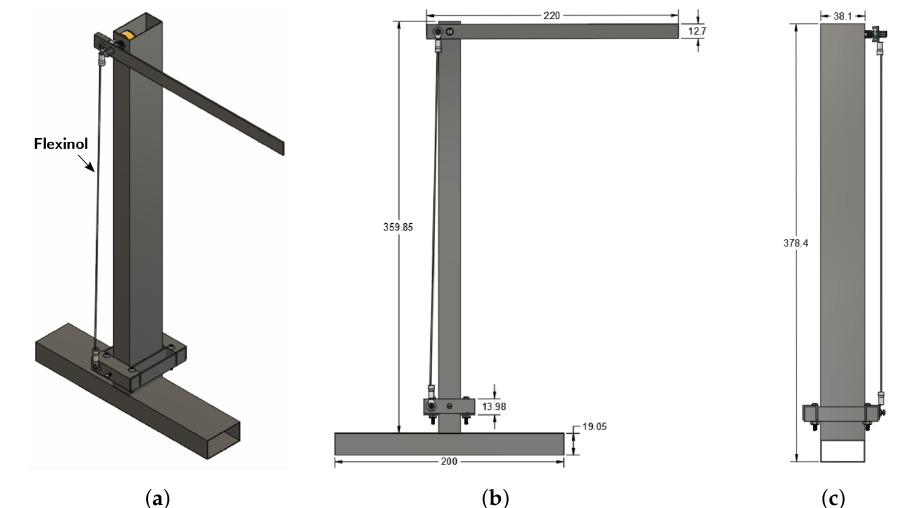
Figure A3. Schematic showing the dimensions in millimeters of the 1-DOF manipulator used in experiments: ( a ) Perspective view; ( b ) Front view; ( c ) Side